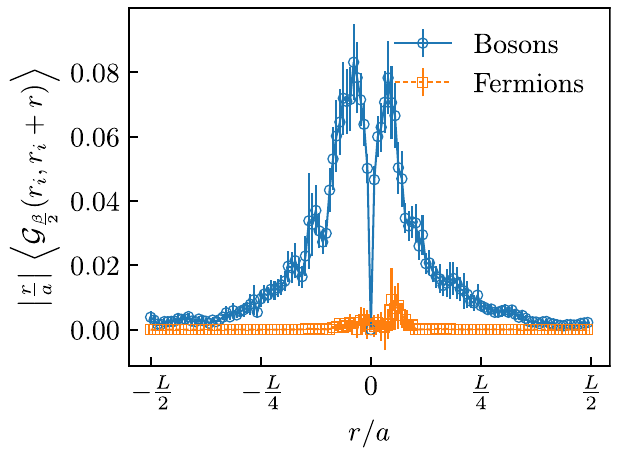
Fig. 8 Disorder-averaged single-particle propagator. Disorder-averaged ð r ; r þ r Þji as functions of the distance r for interacting correlations hj r G τ ¼ β i i 2 bosons (blue circles) and the free fermion (orange squares) systems. Here, r i is chosen so that, for each realization of the disorder, the bosonic G ð r ; r Þ is at its maximum. Data were shown for L = β = 128 and W = 6 i i τ ¼ β 2 and the average is carried over 128 disorder realizations. Vertical error bars indicate the estimated uncertainty extracted from the Monte Carlo simulations and averages over